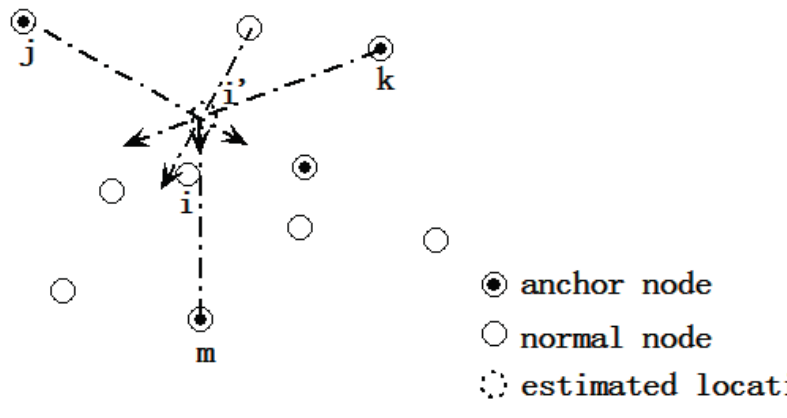
Figure 2. The force exerted on